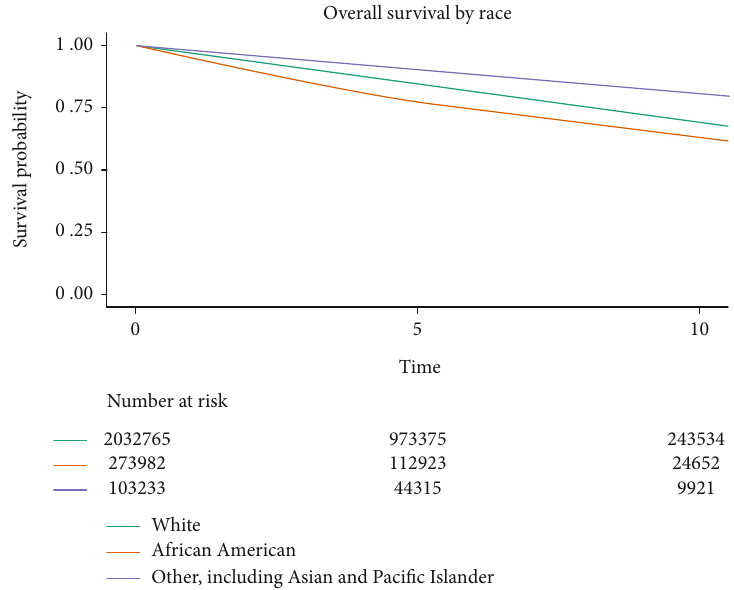
Figure 1: Kaplan-Meier survival curve strati fi ed by